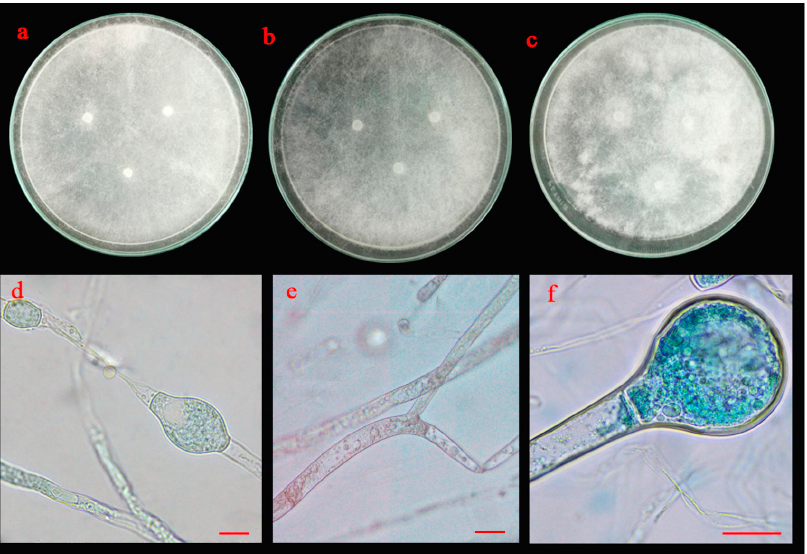
Fig. 5.(B). Morphological characteristics of PB03 isolate: colonies of PB03 isolate on three different media (a; PDA, b; MEA and c; CYA medium); chlamydospores (d), sporangiophore with lake of rhizoid (e) and sporangia and sporangiospore (f); the scale bar = 10